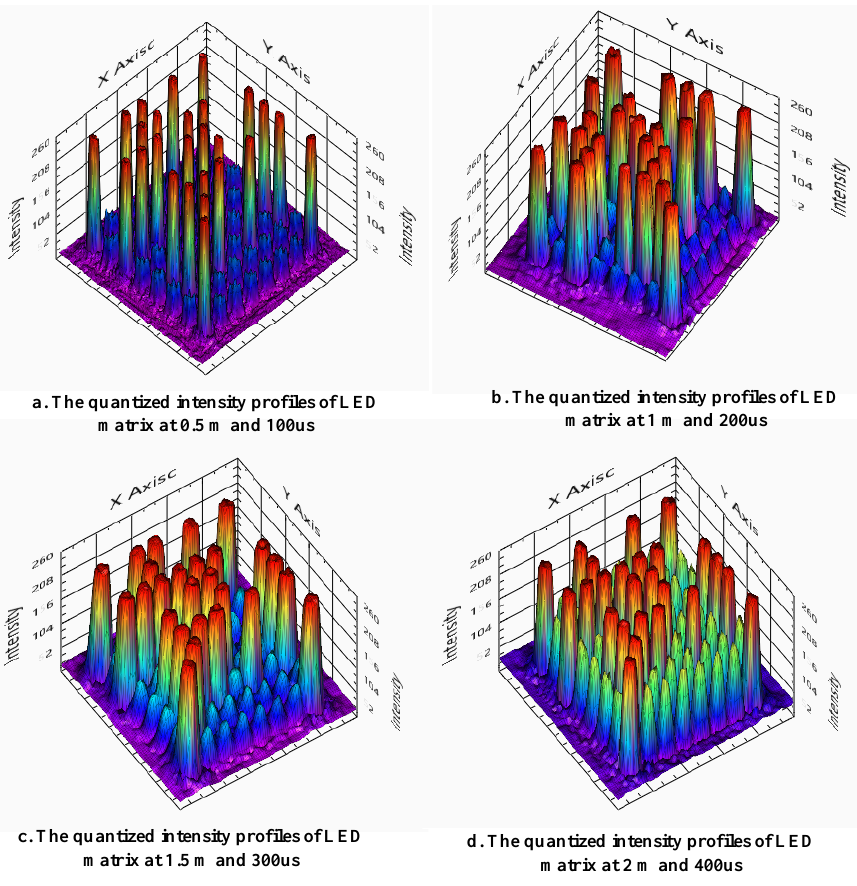
Figure 14. The quantized intensity profile of the LED matrix at ( a ) 0.5, ( b ) 1, ( c ) 1.5, and ( d ) 2 m with different exposure times.